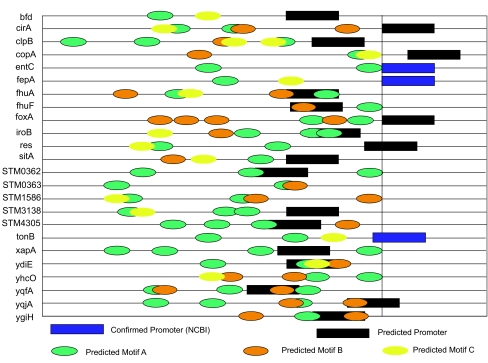
The distribution of motifs in the iron regulated genes cluster. The ORF is open reading frame starting point. The annotated or predicted promoter is indicated in blue and black, respectively. The positions of predicted motifs are indicated by the colored ovals.